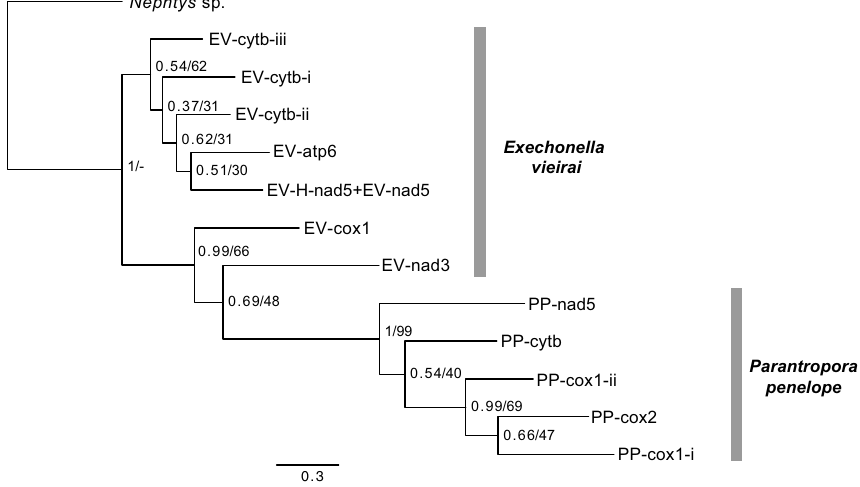
Figure 6. Bayesian analysis of Exechonella vieirai and Parantropora penelope intron sequences constructed using MrBayes v.3.2.6; 5,000,000 generations; 2,500,000 generations burn-in. Introns EV-H-nad5 and EV-nad5 had been concatenated. Ambiguously aligned positions had been excluded using Gblocks v.91b. Posterior probabilities and maximum likelihood bootstrap values (1000 replicates) as estimated using RAxML v.8.2.12 are given at the nodes. Analyses were carried out under the HKY + G model of nucleotide evolution. Reverse transcriptase and intron maturase open reading frames had been removed from EV-cox1 and PP-cox1-i introns. Intron names correspond to those shown in Fig. 2. Branch length scale bar indicates number of substitutions per